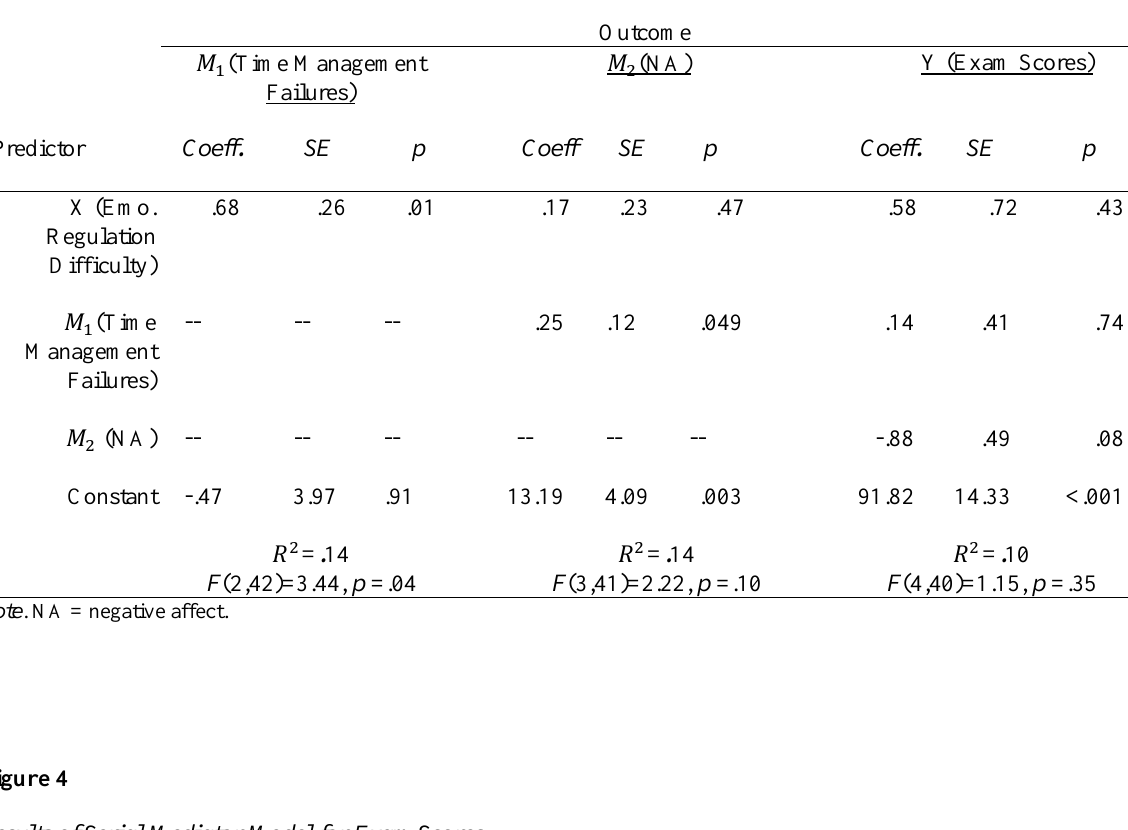
Results of Serial Mediator Model for Exam Scores